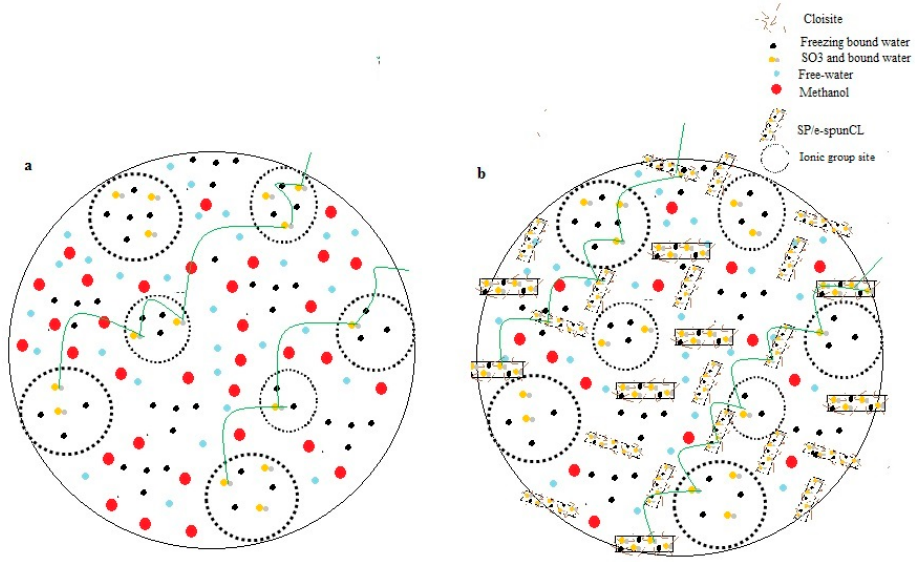
Figure 10. Transport Model of proton and methanol in: ( a ) parent SPEEK; and ( b ) SP/e-spunCL membranes.